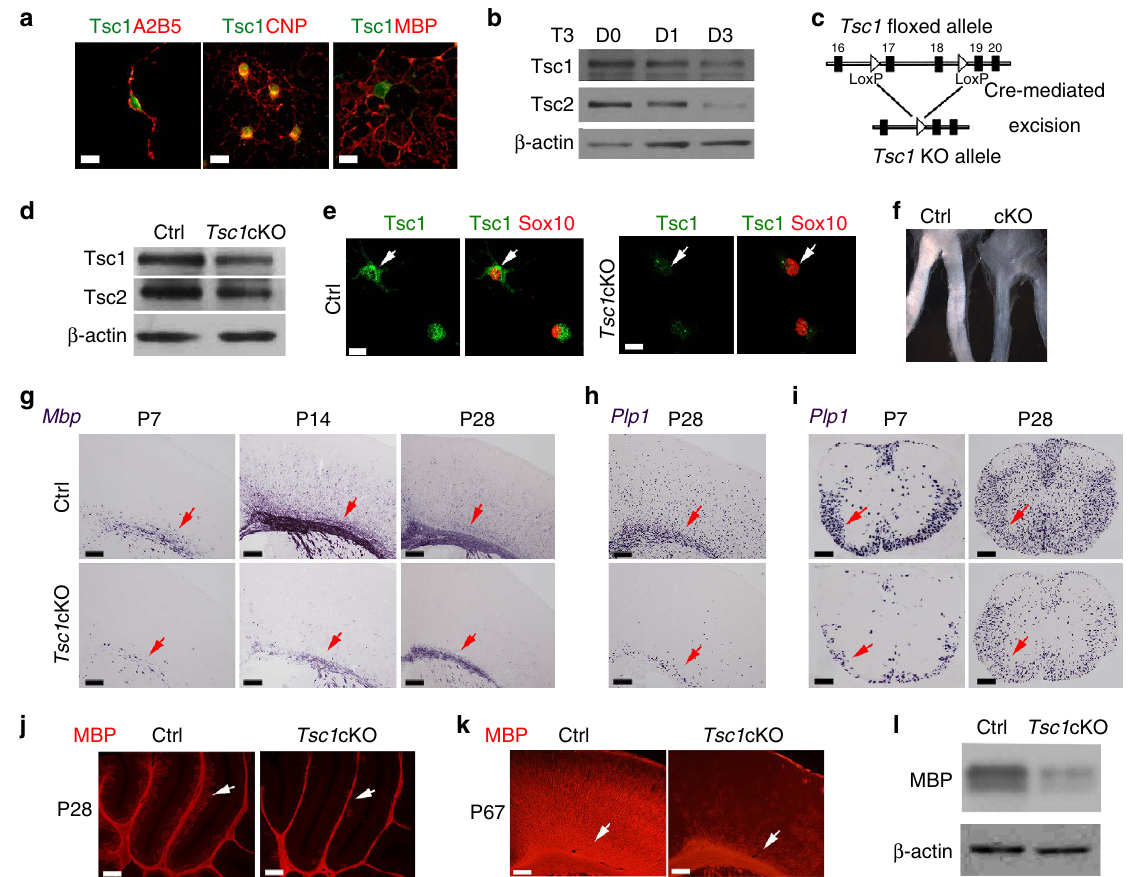
Figure 1 | Tsc1 ablation results in OL differentiation and maturation defects. ( a ) Immunostaining for Tsc1 in OPCs (A2B5 þ ), differentiating and maturating OLs (CNP þ ), terminally differentiated OL (MBP þ ) induced by treatment with T3 for 0, 1 and 3 days (left to right), respectively. Scale bar, 10 m m. ( b ) Expression of Tsc1 and Tsc2 assessed by western blot in OPCs treated with T3 for 0, 1 and 3 days. b -actin was used as loading